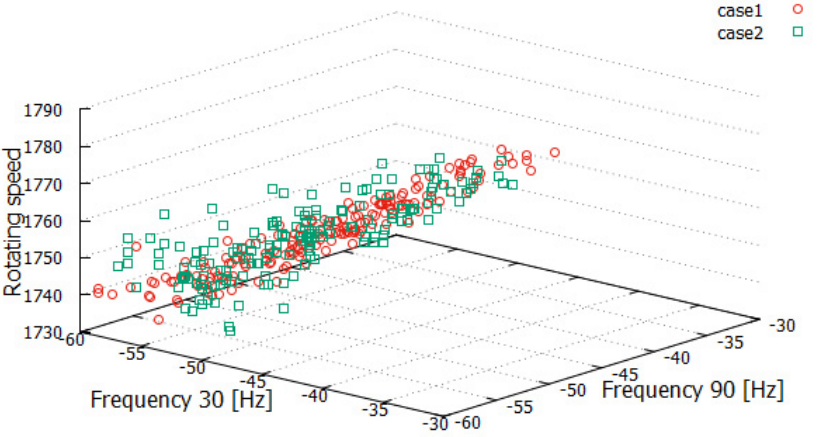
Figure 8. Effect of voltage fluctuation range of power supply on feature distribution of a healthy motor. Table 8. Diagnosis result for No. 7 motor based on machine learning.